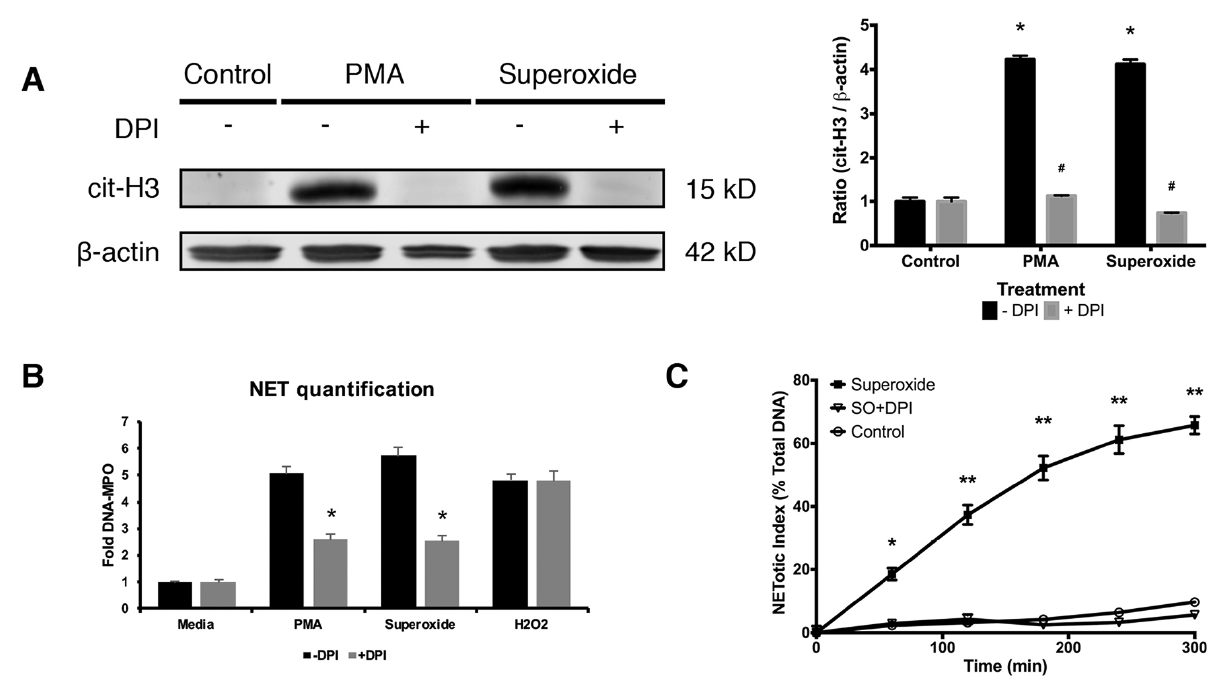
figure 2. Extracellular superoxide induces NETs via NADPH oxidase. Neutrophils were incubated with media alone (negative control); PMA (100 nM), xanthine oxidase (10 mU/mL) and hypoxanthine (500 nM) to yield superoxide; or glucose oxidase (100 mU/mL) to yield hydrogen peroxide, for 1-8 h at 37°C, in the absence or presence of the NOX inhibitor DPI (10 μ M). (A) Western blot of citrulli- nated Histone H3 levels in neutrophils following treatment as above. β -actin is shown as a loading control. Densitometric quantifica- tion charts show mean ± SEM cit-H3 to β -actin, expressed as fold over control. (B) Assay of NET MPO-DNA complexes formed after treatment as above. Shown as mean fold over control. (C) NET formation kinetics in response to superoxide with or without the NOX inhibitor DPI as measured by a fluorescent plate reader assay for extruded DNA fibers (n = 8). NET release is expressed as percent- age of total DNA (n = 8). * p < .05 vs control; # p < .05 vs respective uninhibited treatment. All figures represent at least 3 independent experiments for each